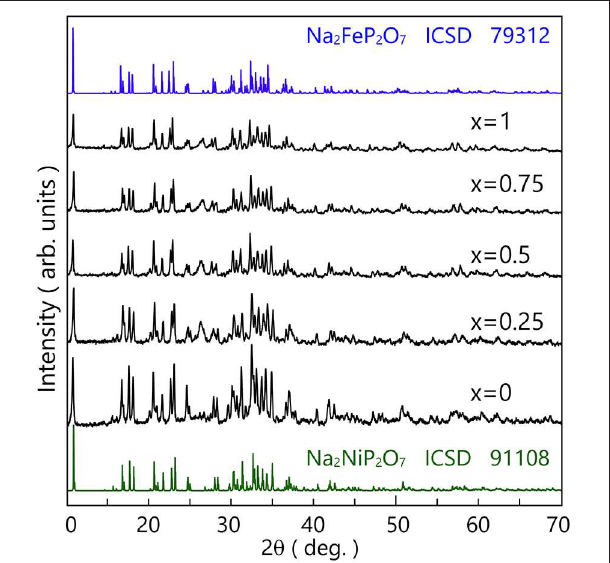
FIGURE 5 | XRD patterns of heat-treated Na 2 Fe x Ni 1 − x P 2 O 7 glass-ceramics with